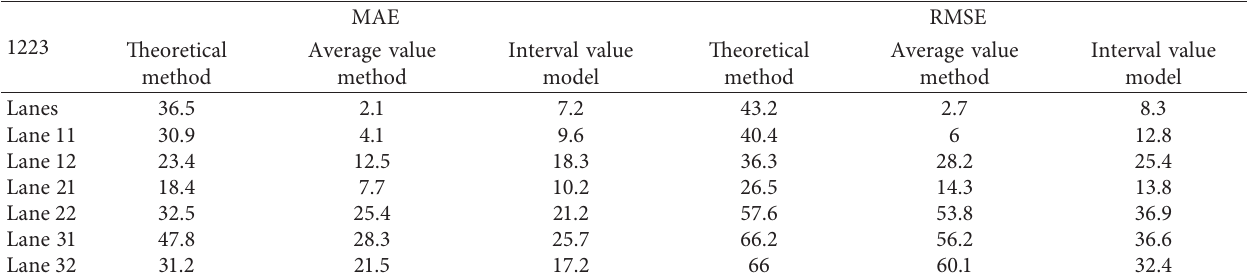
Table 7: Data fitting accuracy by MAE and RMSE on December 23, 2015.